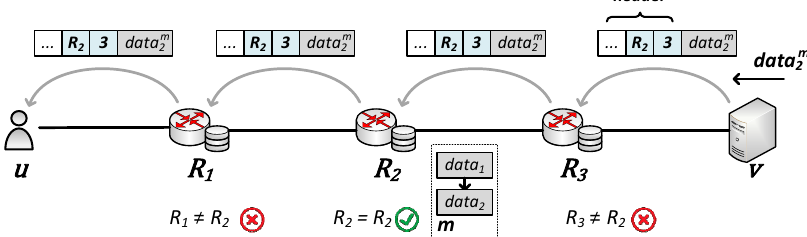
Figure 7. Forwarding process of subsequent request packets.